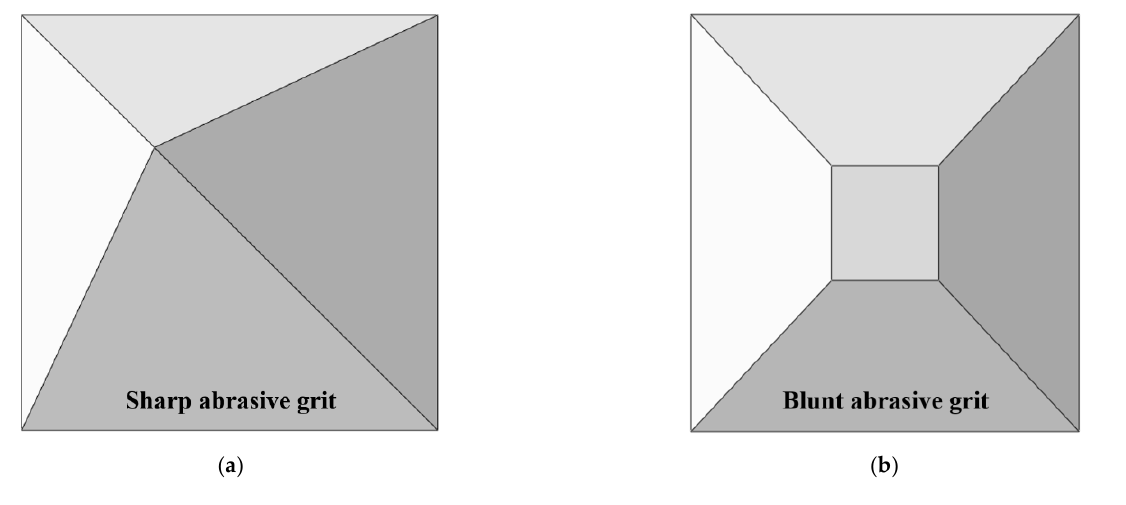
Figure 5. Simulation models of different grits after wear: ( a ) Sharp abrasive grit, ( b ) blunt abrasive grit.